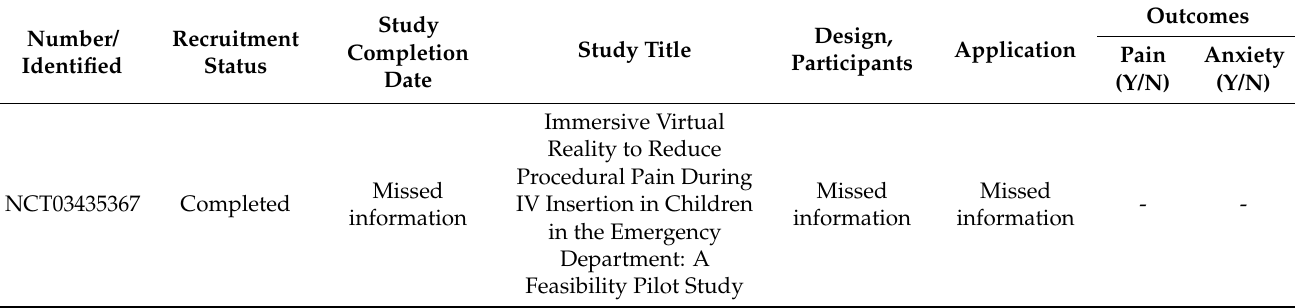
Table 3. Ongoing studies investigating the effectiveness of VR in the management of pain and anxiety in pediatric cancer patients.